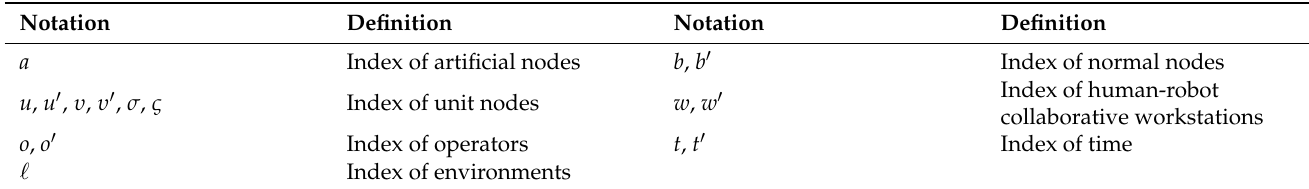
Table 1. The indices used in the model.